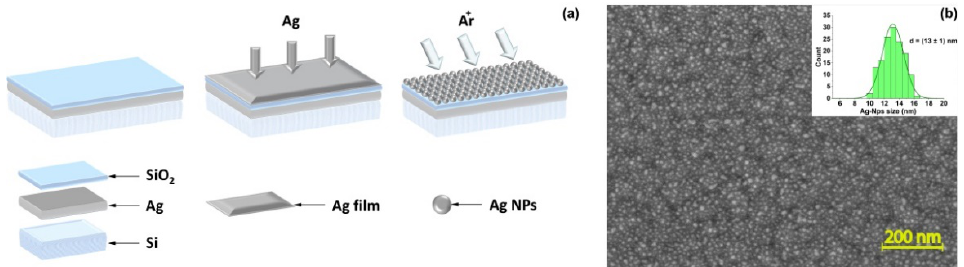
Figure 3. ( a ) Scheme of the fabrication of the hybrid plasmonic sandwiched structure: films of Ag, SiO 2 , Ag stepwise formed by electron beam sputtering with the further formation of a plasmonic silver-based structure through the Ar ion beam treatment of the top Ag film. ( b ) A typical SEM image of the sensor element decorated by Ag nanoparticles. The inset shows a size distribution of silver nanoparticles on the sensor element.